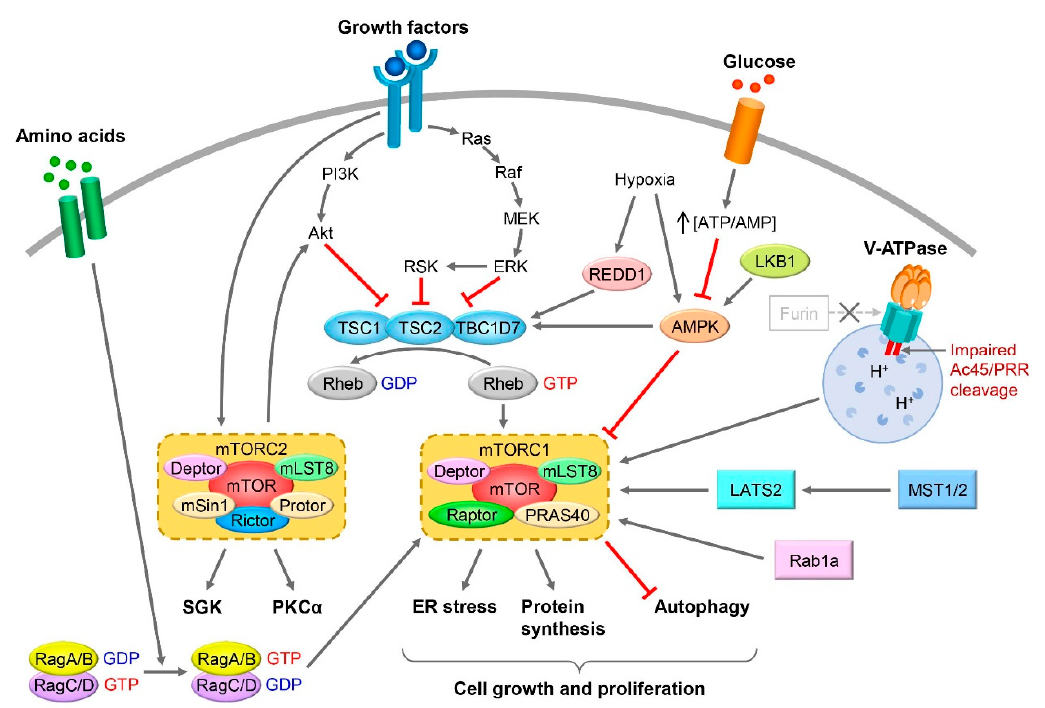
Figure 1. mTORC1 and mTORC2 activation signals in cells. In cells, mTORC1/2 is activated by growth factors, glucose, and amino acids. In particular, mTORC1 positively and negatively regulates cell growth and proliferation through protein synthesis, ER stress, and inhibition of autophagy. Gray arrows indicate activation, line segments in red indicate inactivation. The symbol of cross means that the action of Furin on V-ATPase is inhibited [30].